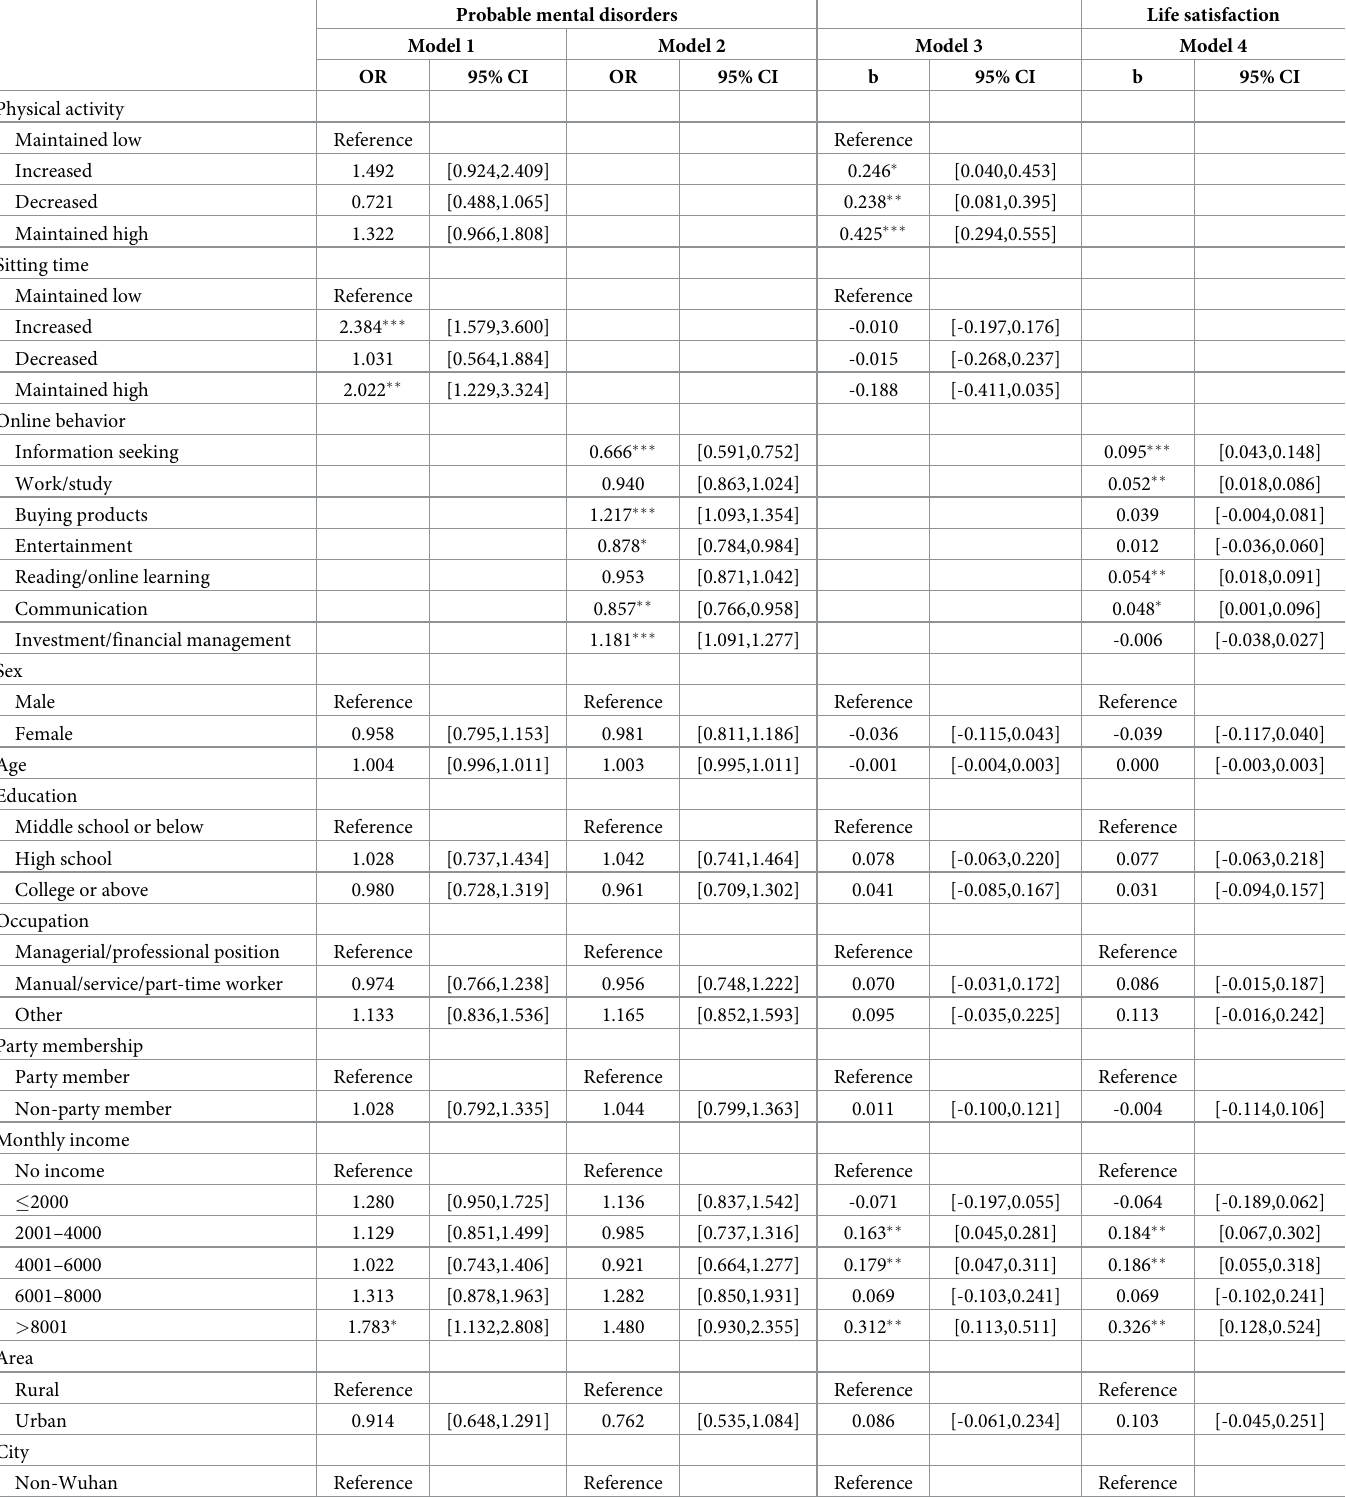
Table 3. Adjusted associations between self-reported changes in behavior before and during the COVID-19 pandemic and mental health and life